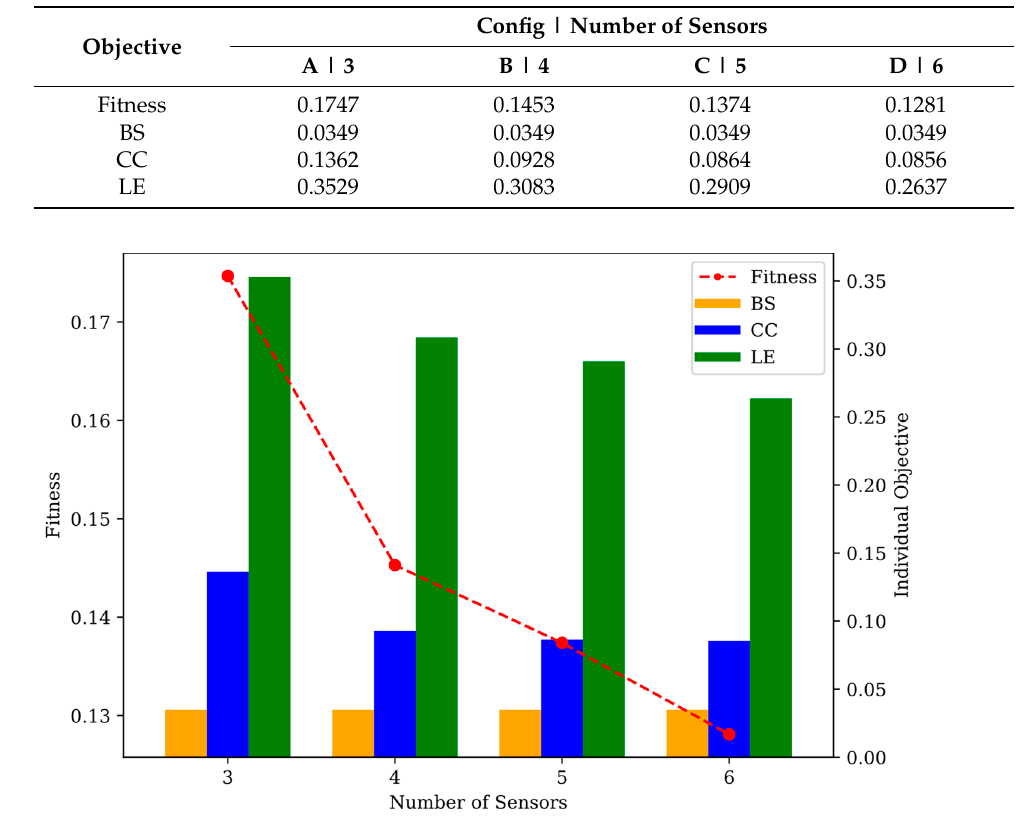
Figure 10. Performance comparison graph for NET-B.